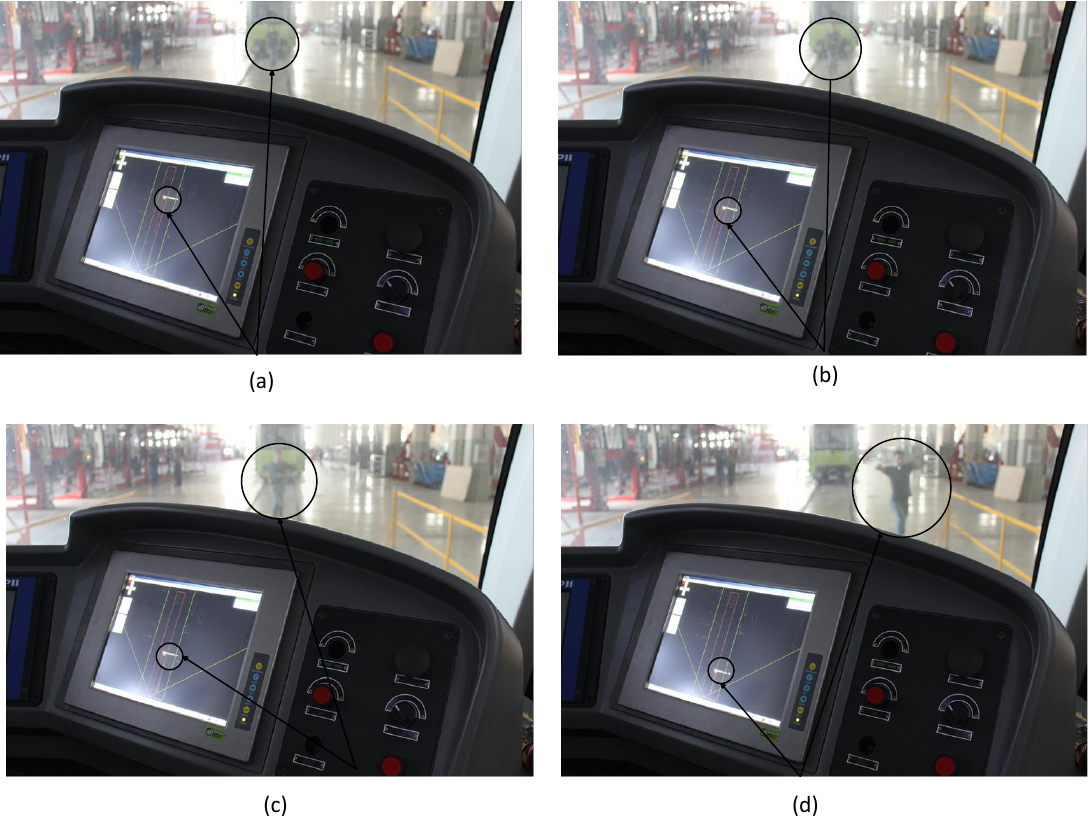
Figure 12. The scenarios for a pedestrian approaching the test vehicle. ( a ) A pedestrian running towards the test vehicle with a velocity of 5 km/h; ( b ) A pedestrian running towards the test vehicle with a velocity of 11 km/h; ( c ) A pedestrian running towards the test vehicle with a velocity of 14 km/h; ( d ) A pedestrian running towards the test vehicle with a velocity of 13 km/h but changes direction when an acoustic alarm is activated.